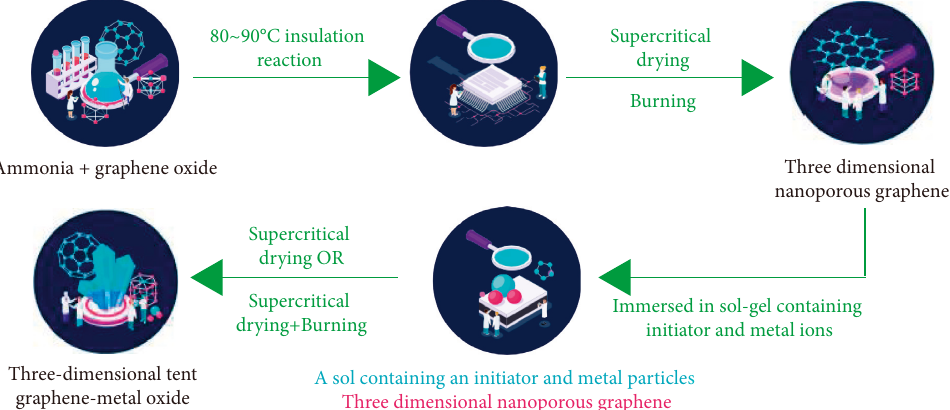
Figure 1: Iridium oxide nanoscale drug-carrying